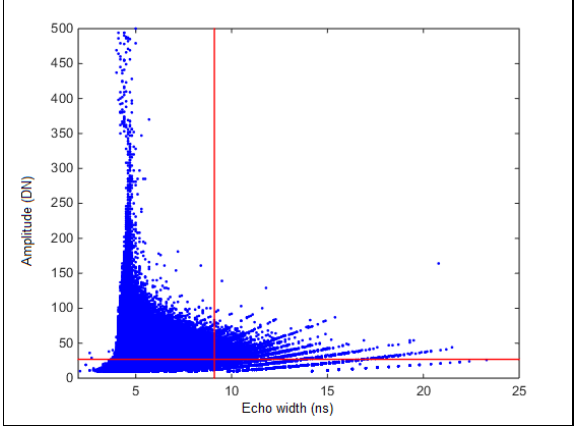
Figure 7. Eisenstadt dataset, Scatterplot of Echo Width versus Amplitude for the first-of-many echoes. The red horizontal line separates the weak (66.6%) from the strong echoes (“highest third”). The vertical line shows the maximum echo width EW max which is the EW at the 99% quantile of the strong echoes.